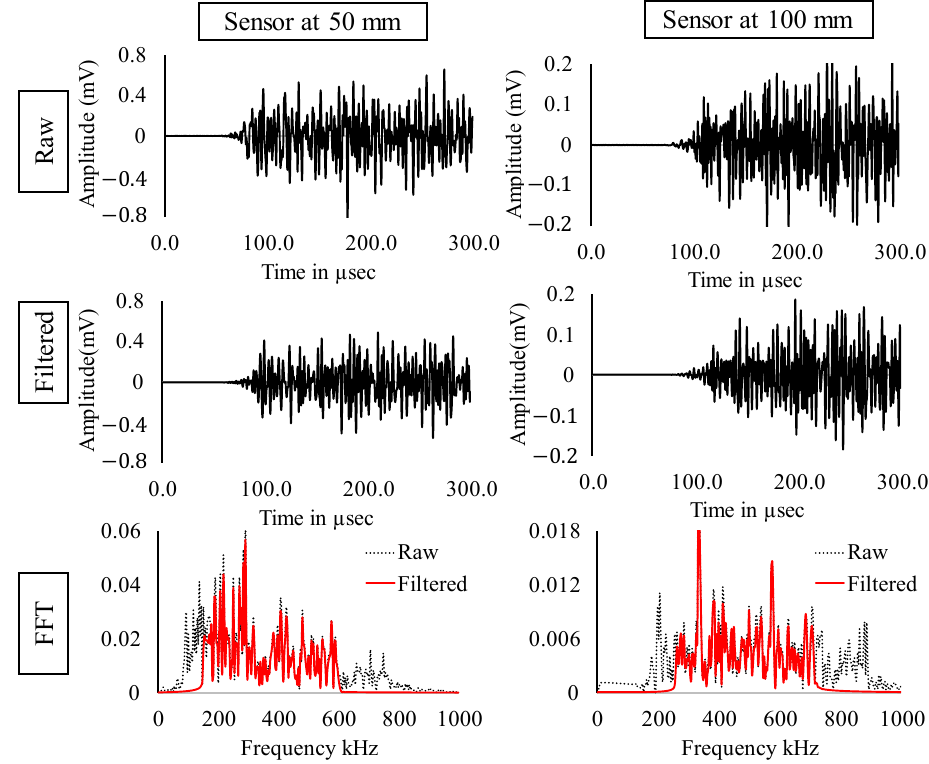
Figure 14. Raw, filtered and FFT of AE signals occurring at load = 150 kN.